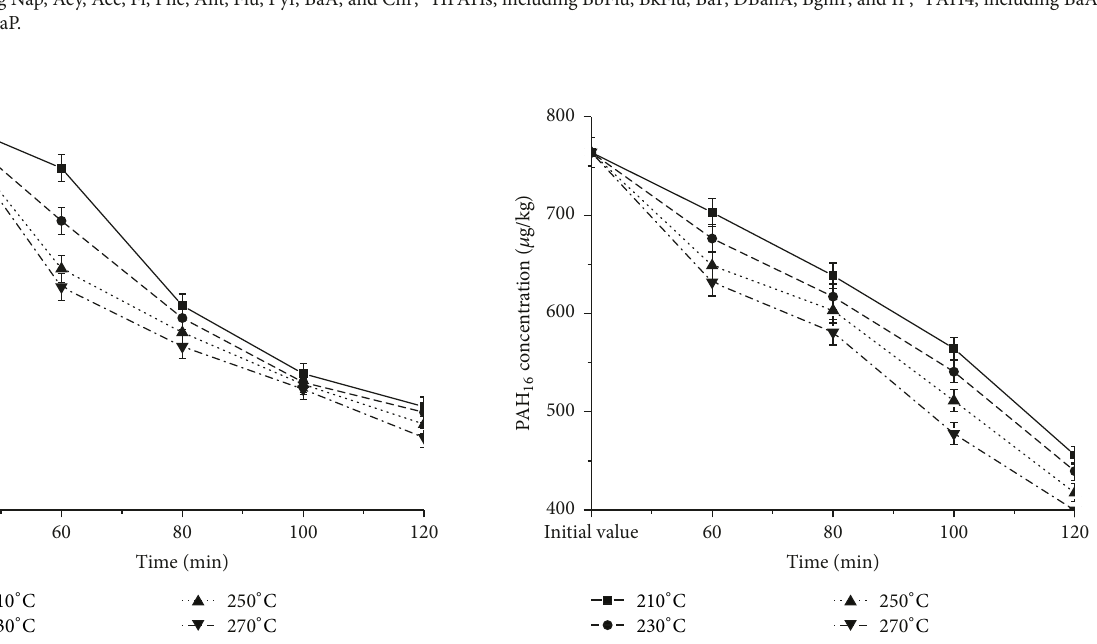
a broad range of PAHs concentrations in crude vegetable oil. Phe, Flu, and Pyr were the three kinds of compounds with the highest concentrations; levels of 3 analytes were 212.74 ± 8.66, 135.80 ± 9.01, and 71.60 ± 5.48 𝜇 g/kg, respectively. DBahA was the lowest one oppositely, with the concentration of 2.84 ±